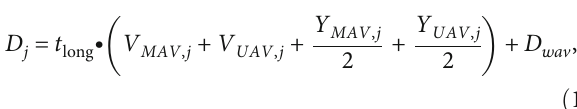
Figure 4: Three-dimensional space minimum safety interval.